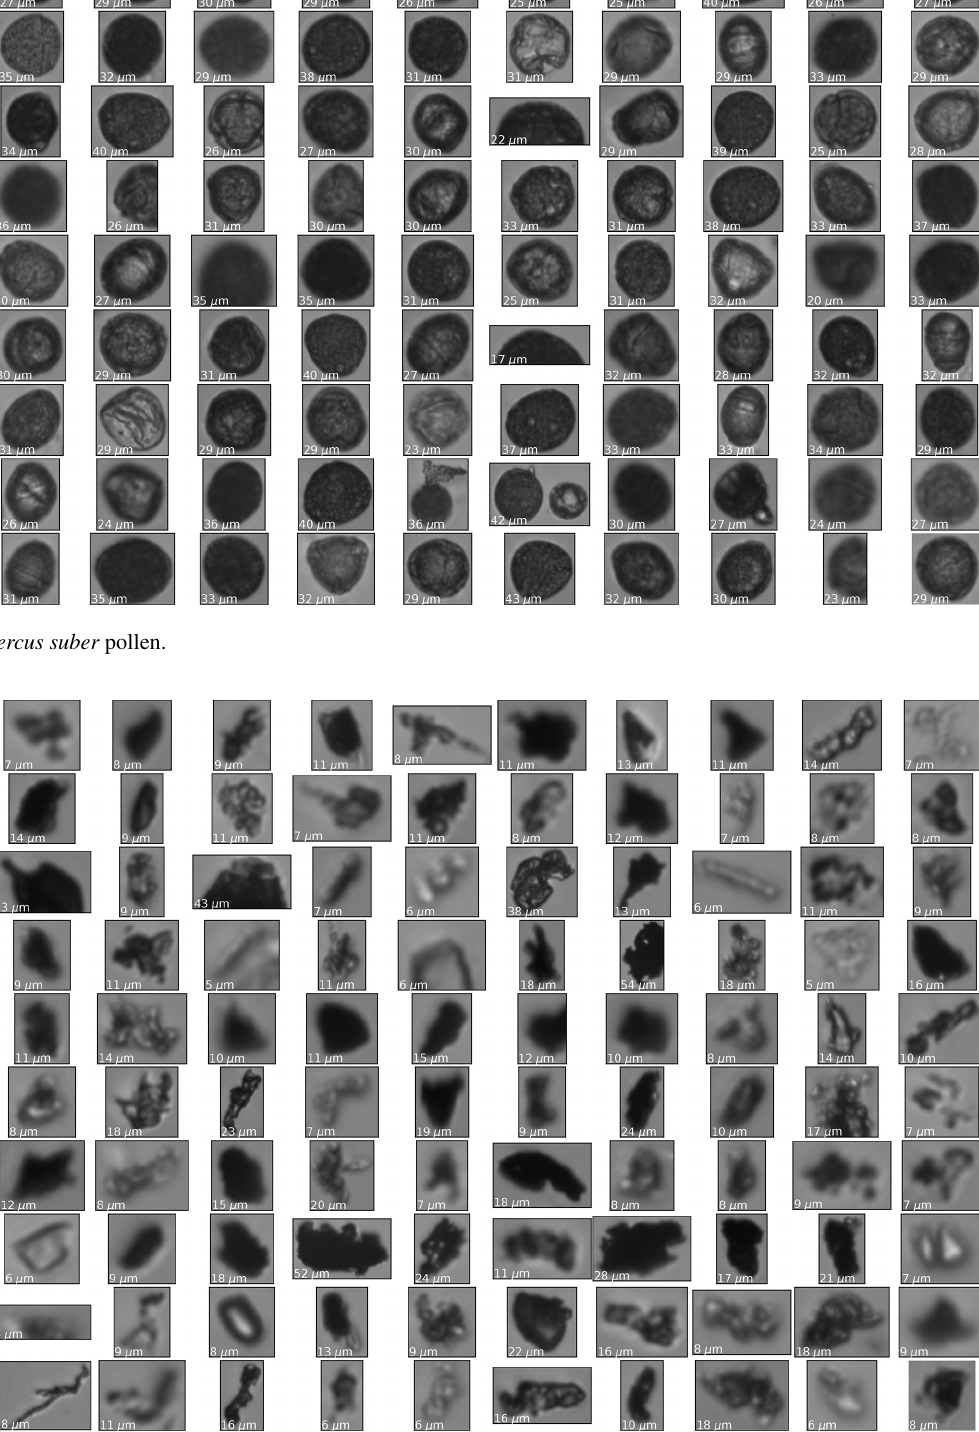
Figure C7. Contamination/blurry